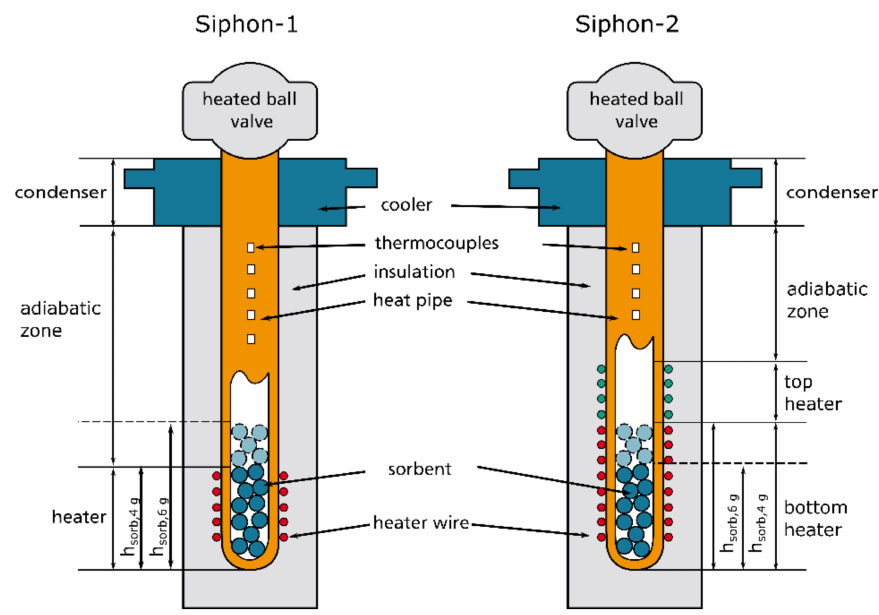
Figure 2. Heat pipe (i.e., thermosyphon) demonstrators Siphon-1 and